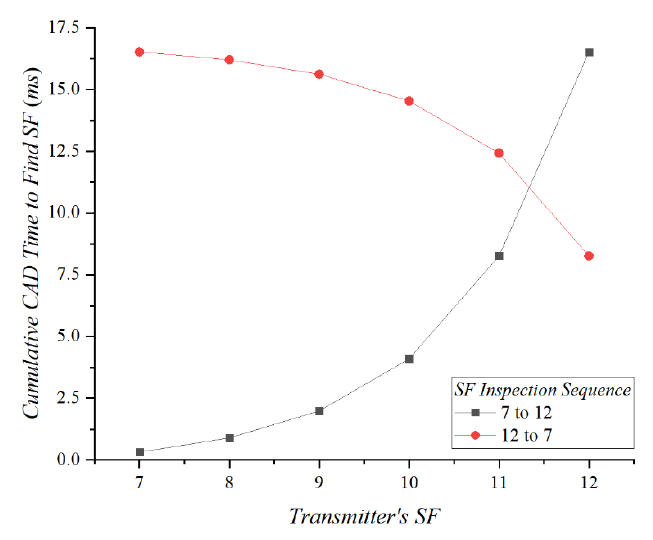
. Figure 1. An example of the ASFS operation. In ASFS, the number of steps in the SF inspection sequence determines the preamble sampling time for finding a proper SF. As in Equation (6), if BW is constant, the CAD time exponentially increases according to the SF value. Figure 2 shows the theoretical cumulative CAD time needed to find the SF of the transmitter by using the SF inspection sequence. If the receiver examines the